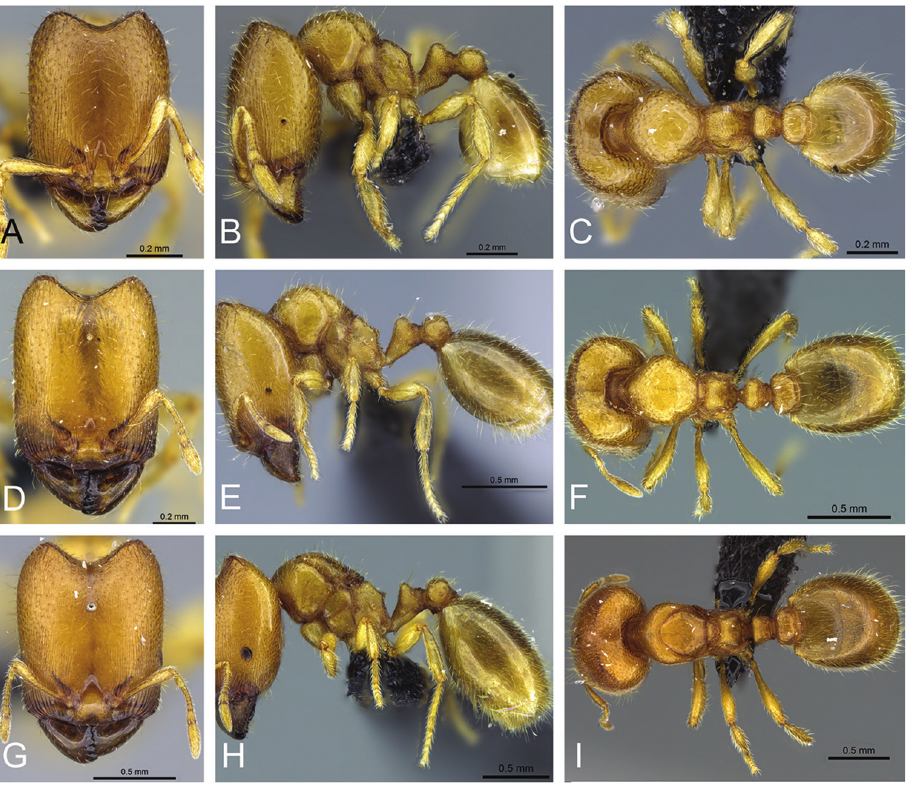
Figure 60. Intermediates of Carebara raberi . Major workers, CASENT0140591: A head in full-face view B body in profile view C body in dorsal view. CASENT0056920: D head in full-face view E body in profile view F body in dorsal view. CASENT0140693: G head in full-face view H body in profile view I body in dorsal